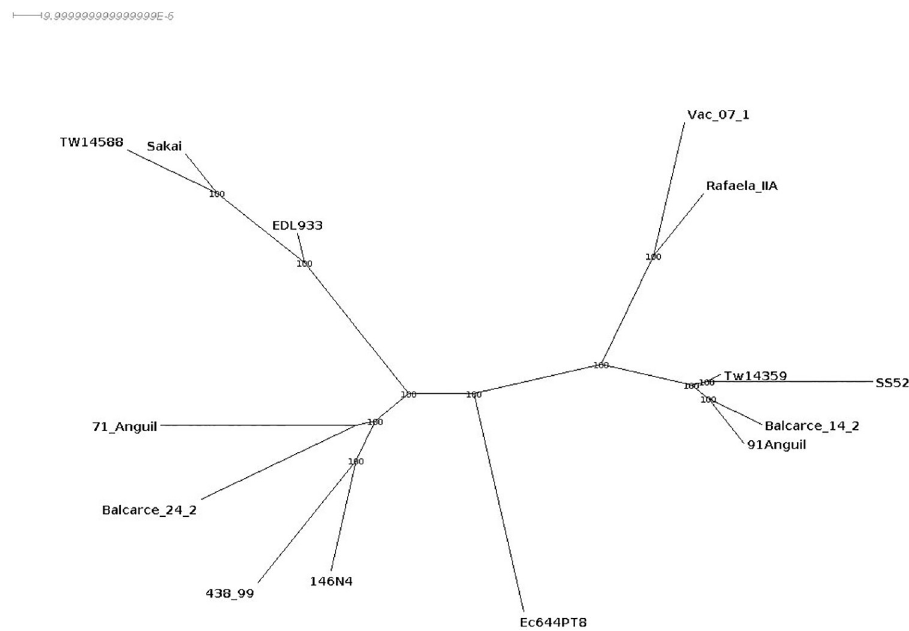
Fig 2. Phylogenetic tree constructed with the core genome from the Argentinian strains and previously published strains using RAxML. Bootstrap values are located at each branch point.